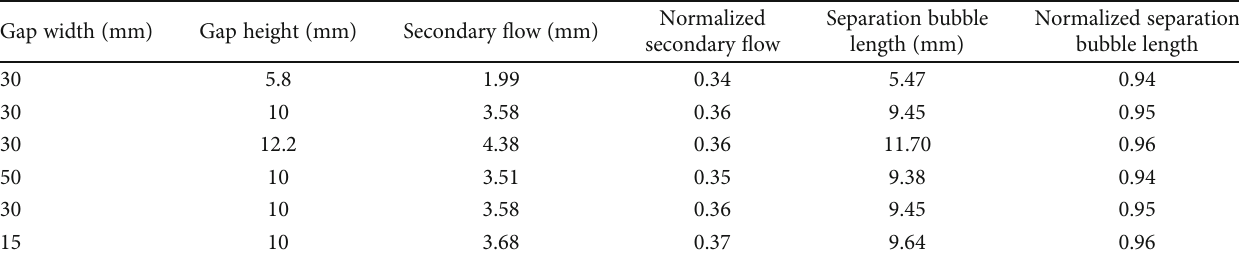
Table 3: Comparisons of the separation bubble lengths obtained from the experiments and simulations. Experimental Gap width Gap height (mm) (mm) length